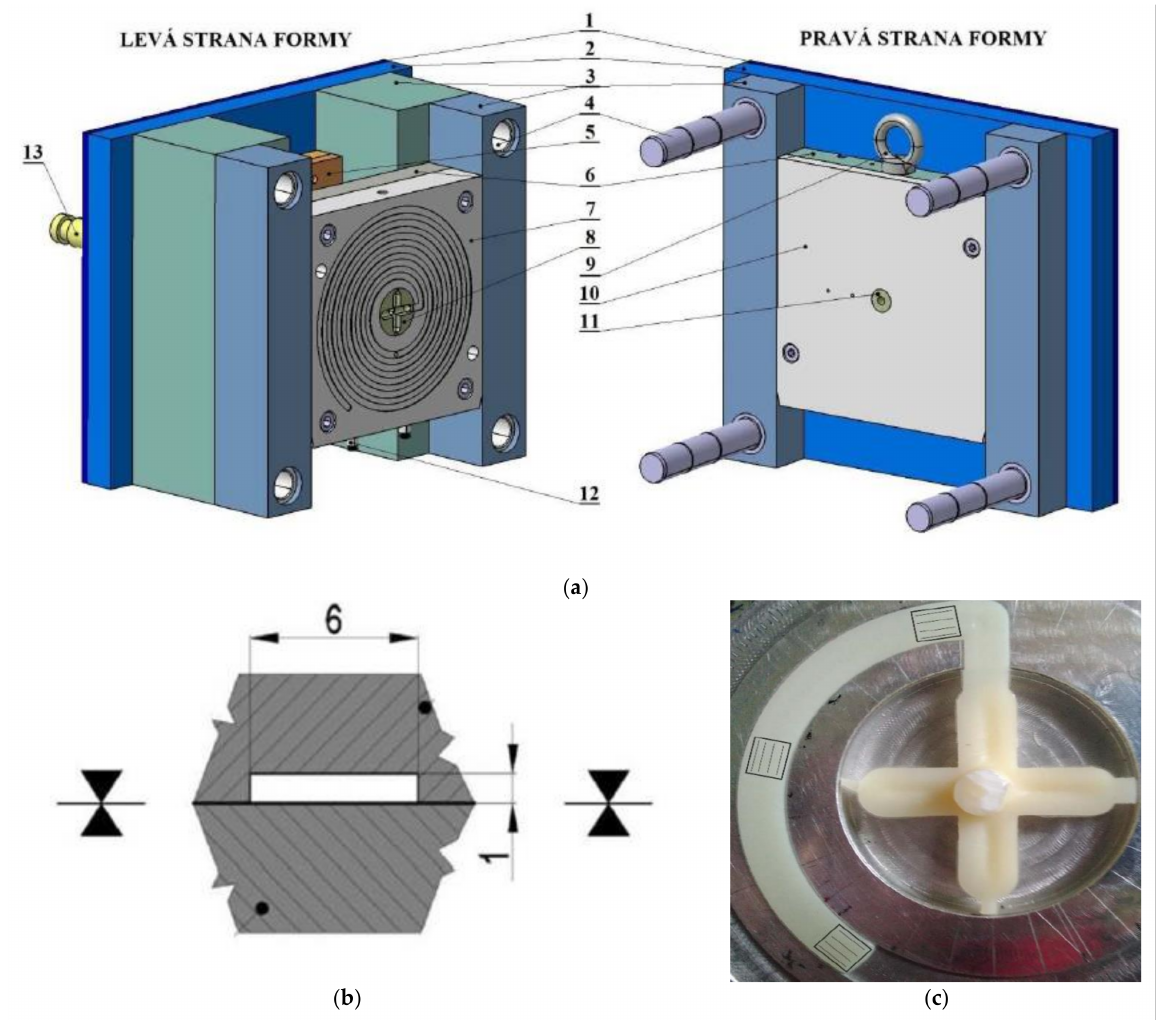
Figure 2. ( a ) 3D model of the test injection mould; ( b ) cross-section of the cavity; ( c ) area of surface quality measurement: 1—heat insulation board 2—clamping plates, 3—spacer block, 4—guiding elements, 5—ejection system, 6—backing plate,